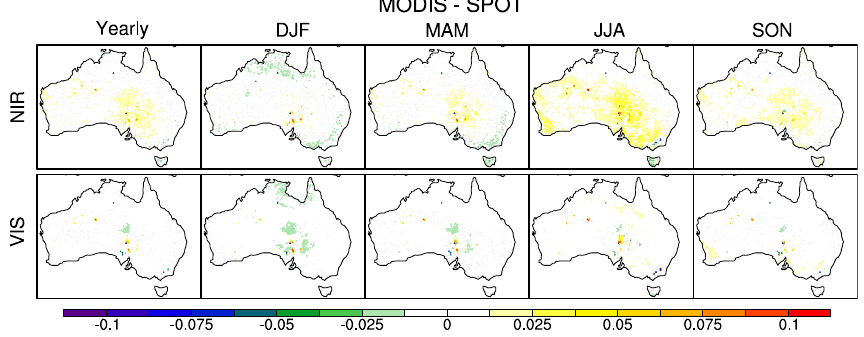
Figure 4. Yearly and seasonal difference between MODIS and SPOT (MODIS-SPOT) VIS and NIR black-sky albedo.